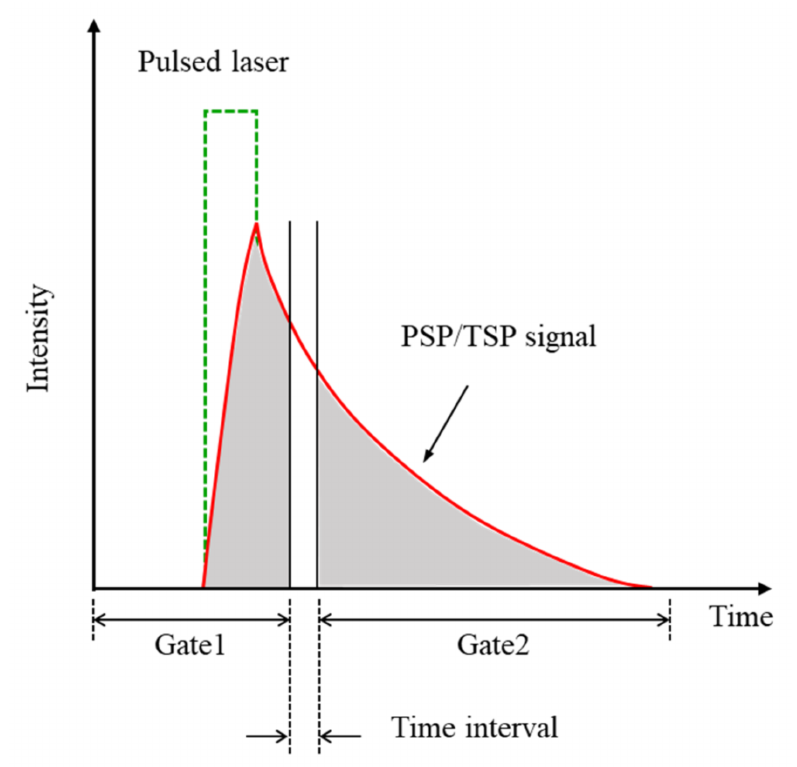
Figure 4. Schematic of single-shot lifetime-based